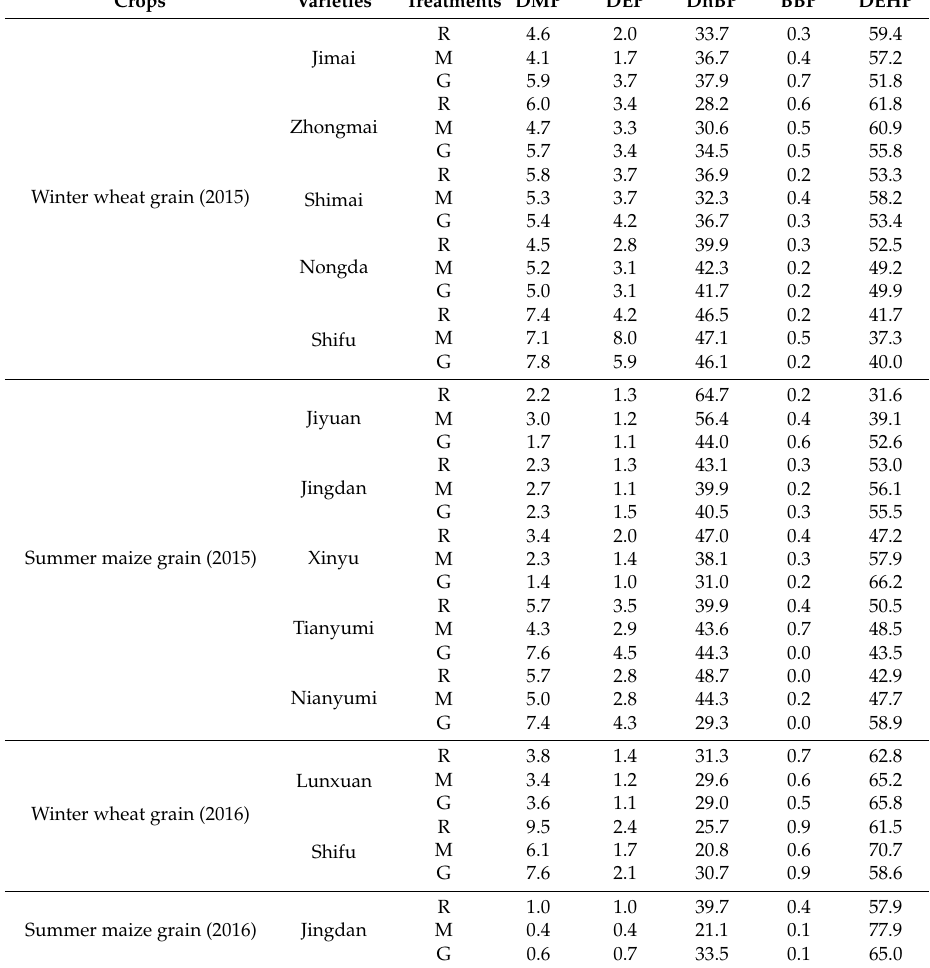
Table 6. The ratio of each individual PAE to the total 6 PAEs for cereal grains in 2015 and 2016 Unit: %. Crops Varieties Treatments DMP DEP DnBP BBP